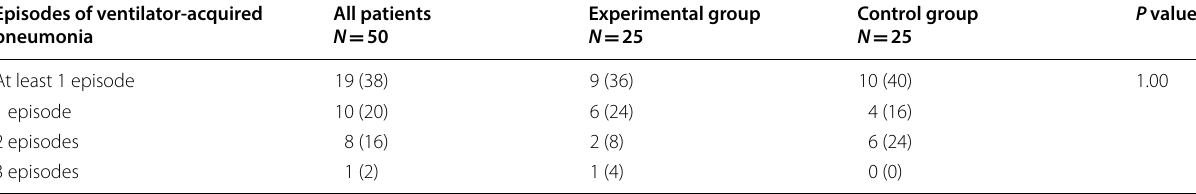
Data are expressed as number (percentage)